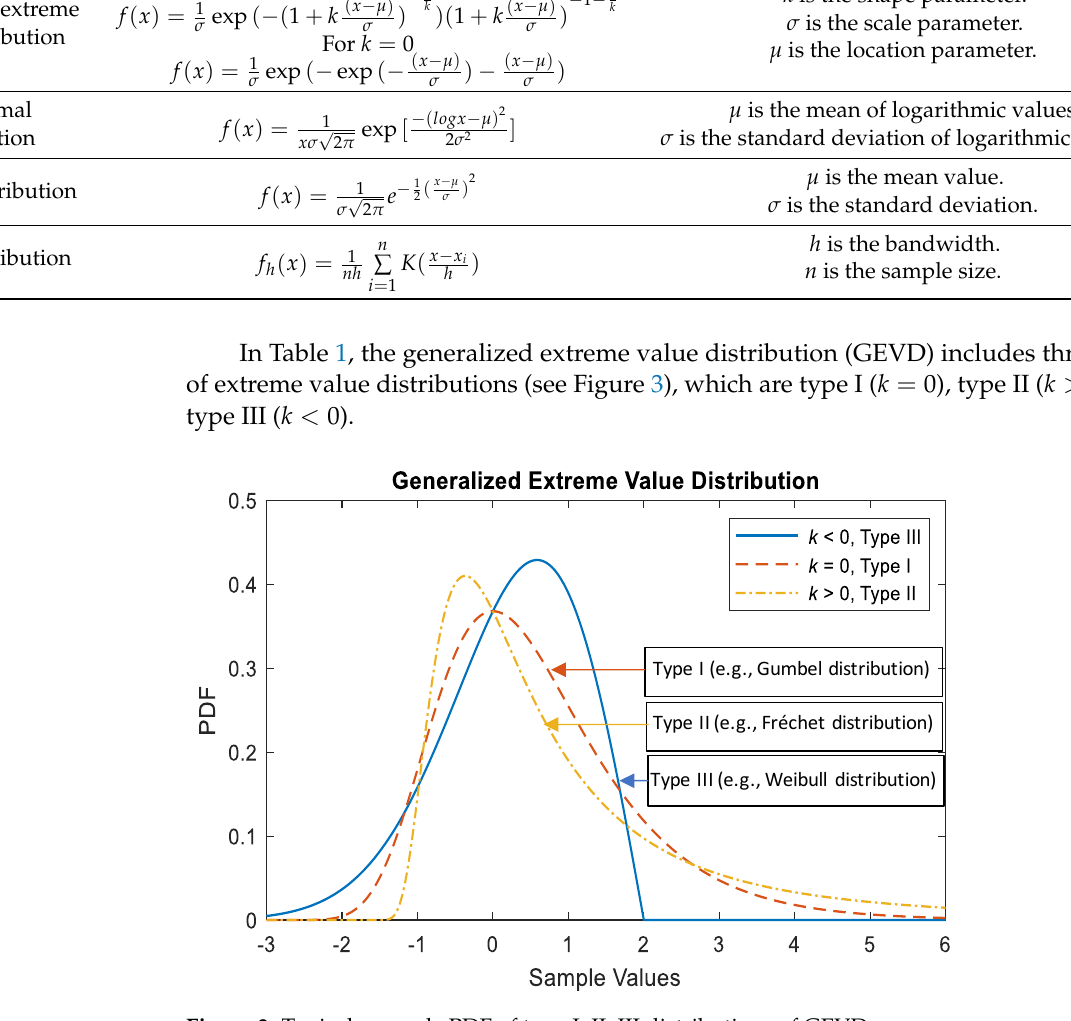
Figure 3. Typical example PDF of type I, II, III distributions of GEVD.